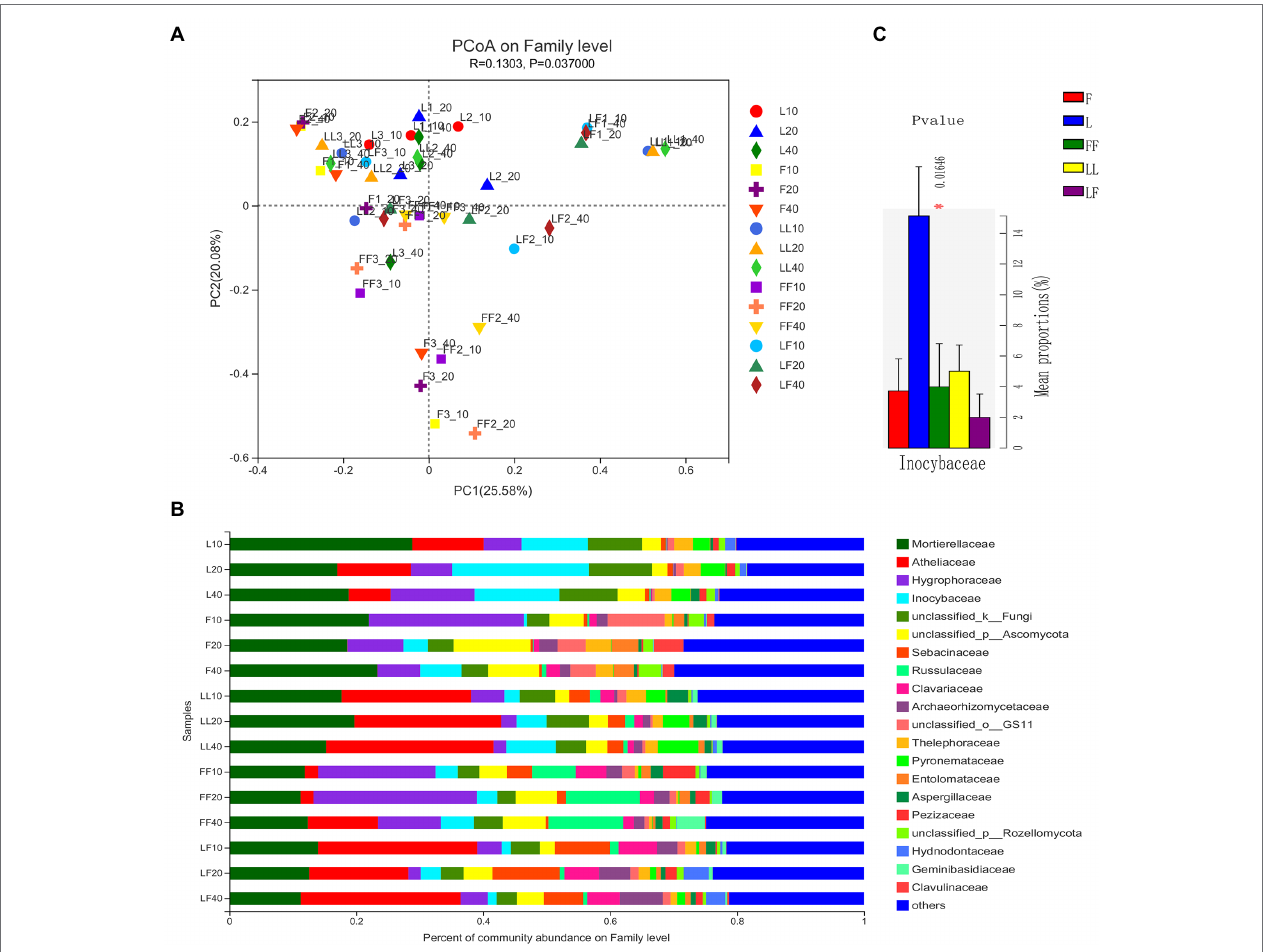
FIGURE 5 | Fungal community composition in different soil samples. (A) Principal coordinates analysis of fungal community composition. (B) Fungal community structure at the level of family. (C) The results of Kruskal–Wallis H test on the difference of Inocybaceae in different soil samples. Refer to Figure 1 legend for relevant